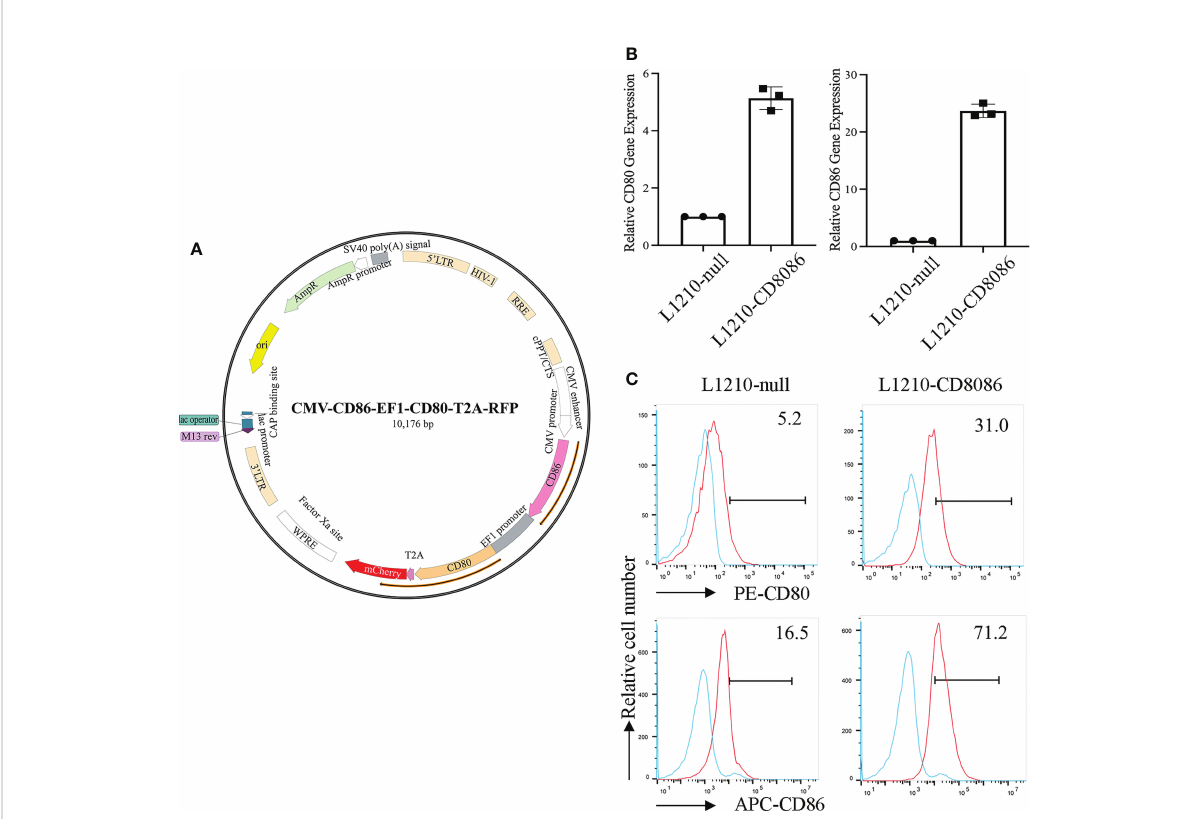
FIGURE 1 Construction of a lentiviral vector encoding costimulatory molecules and transduction of the L1210 cells. (A) The map of a lentiviral vector encoding CD80 and CD86. (B) The expression of CD80 and CD86 in L1210-null and L1210-CD8086 cells was quanti fi ed by real-time PCR and fl ow cytometry (C) . Data in (B) are presented as mean ± SD. P values are evaluated by Student ’ s t